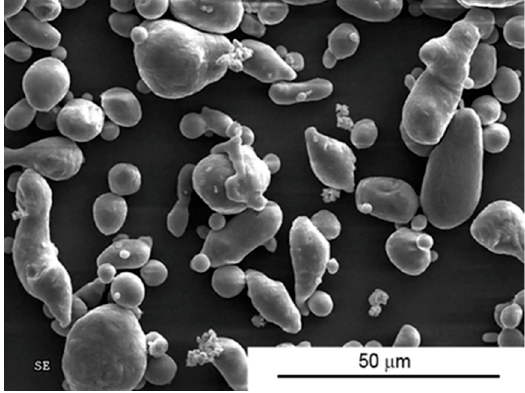
Figure 1. Morphology of AA6061 powder.